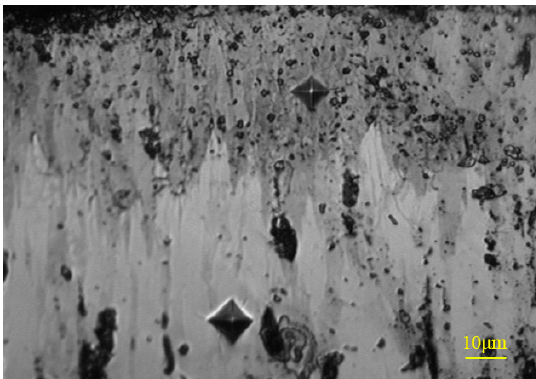
Figure 5. Coating hardness test.